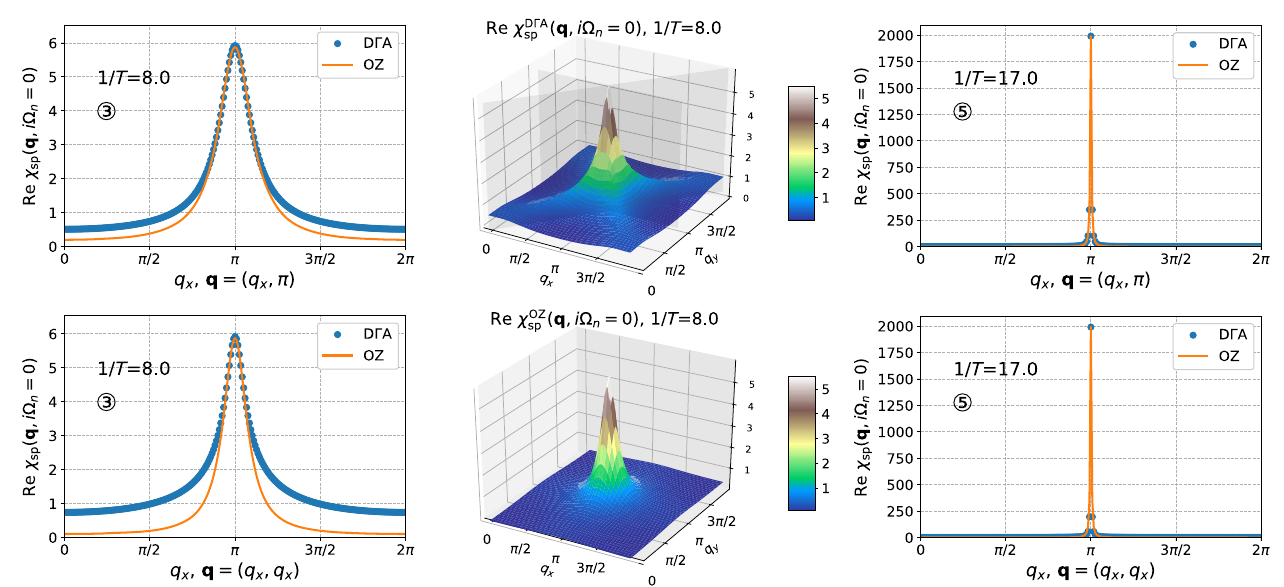
FIG. 21. Comparison between the static antiferromagnetic susceptibilities obtained from D Γ A and fits to an Ornstein-Zernike form (see Appendix A and Figs. 25 and 27 for the corresponding fit parameters). In the temperature regime around 1 =T ¼ 8 , the D Γ A susceptibility has, in addition to the antiferromagnetic peak at Q ¼ ð π ; π Þ , important contributions associated with the nesting vectors of ; (cid:3) q the form ð q ( “ ridges ” in the upper middle panel). Although describing the vicinity of Q ¼ ð π ; π Þ accurately, the Ornstein-Zernike x x Þ form does not account for these contributions (lower middle panel). At lower temperatures, these contributions become negligible. The gray planes in the middle upper panel indicate the cuts shown, i.e., q ¼ ð q